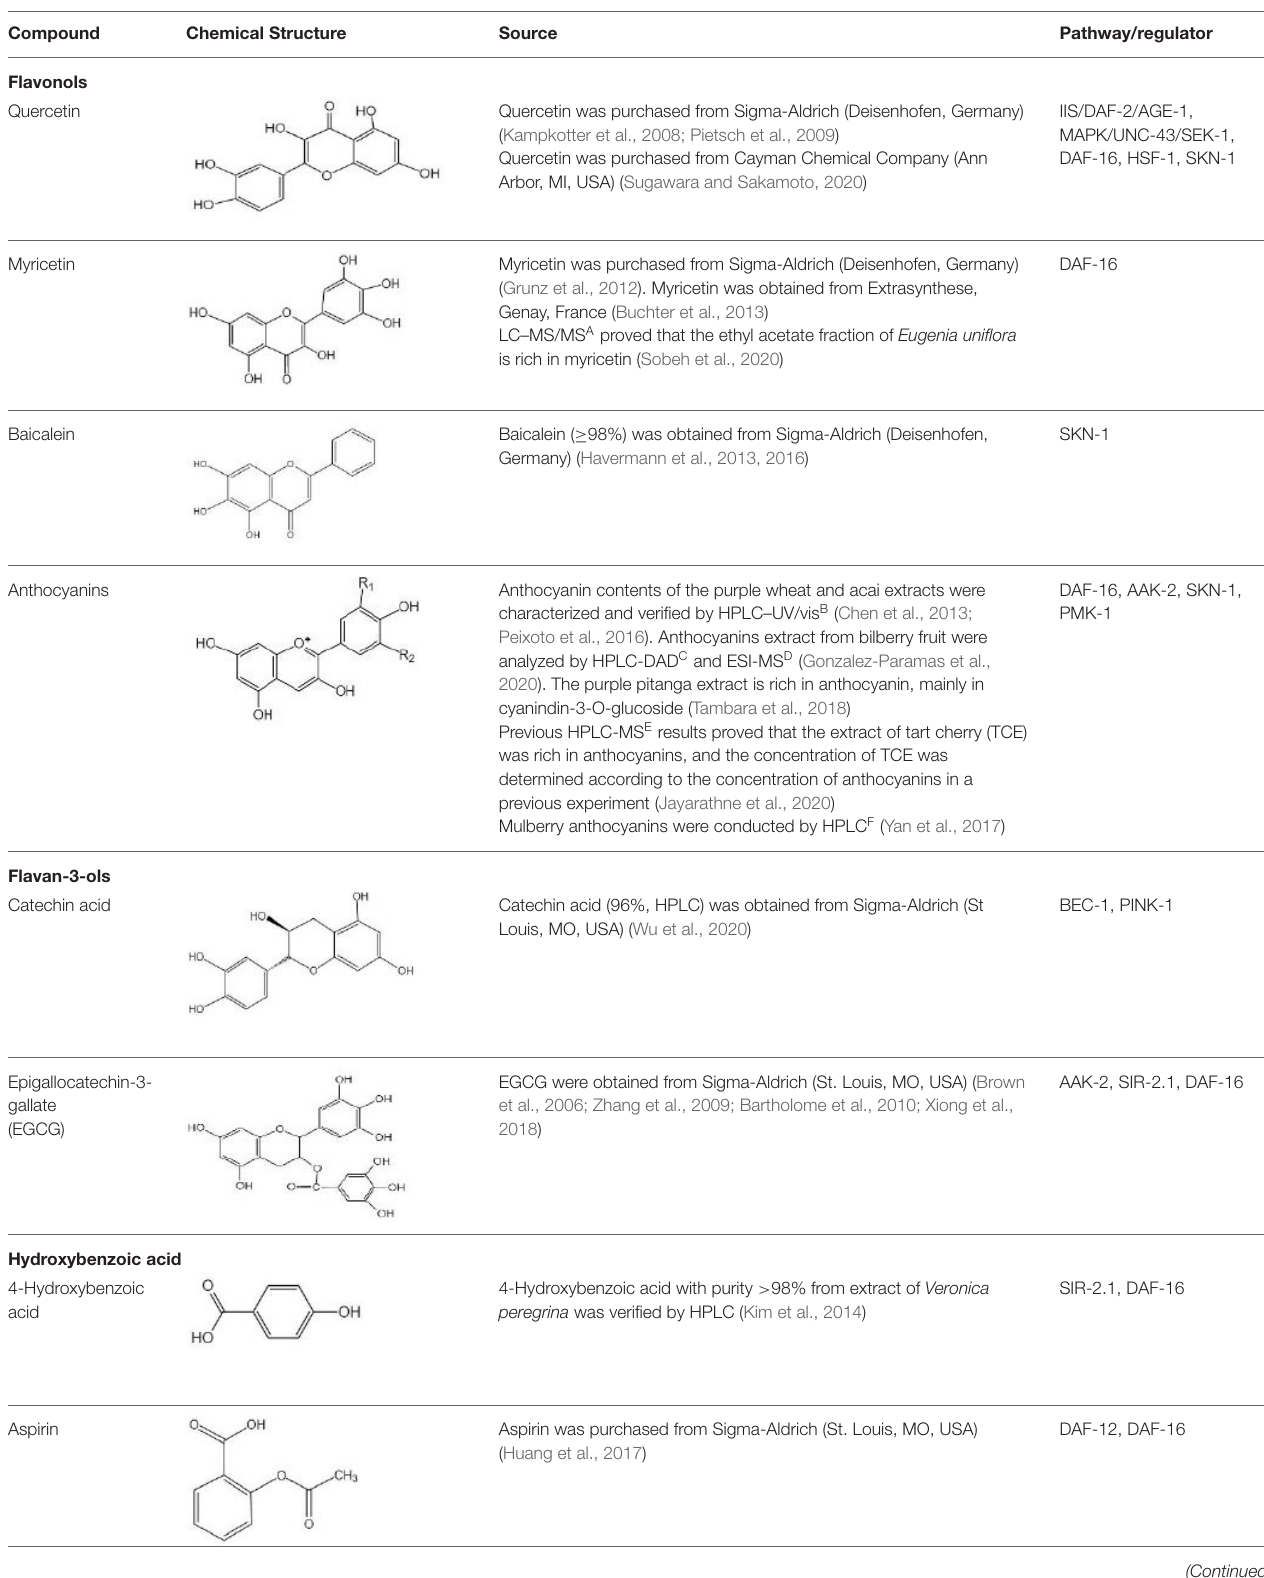
TABLE 1 | Modulation of the lifespan in Caenorhabditis elegans by